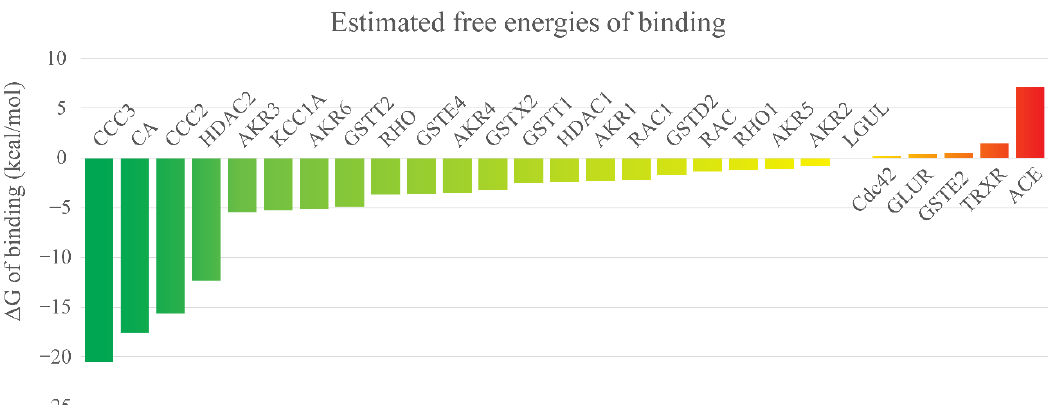
Figure 3. Predicted free energies of binding of compound 8 to its potential targets. The color scale goes from best (green) to worst (red) ΔGs of binding.